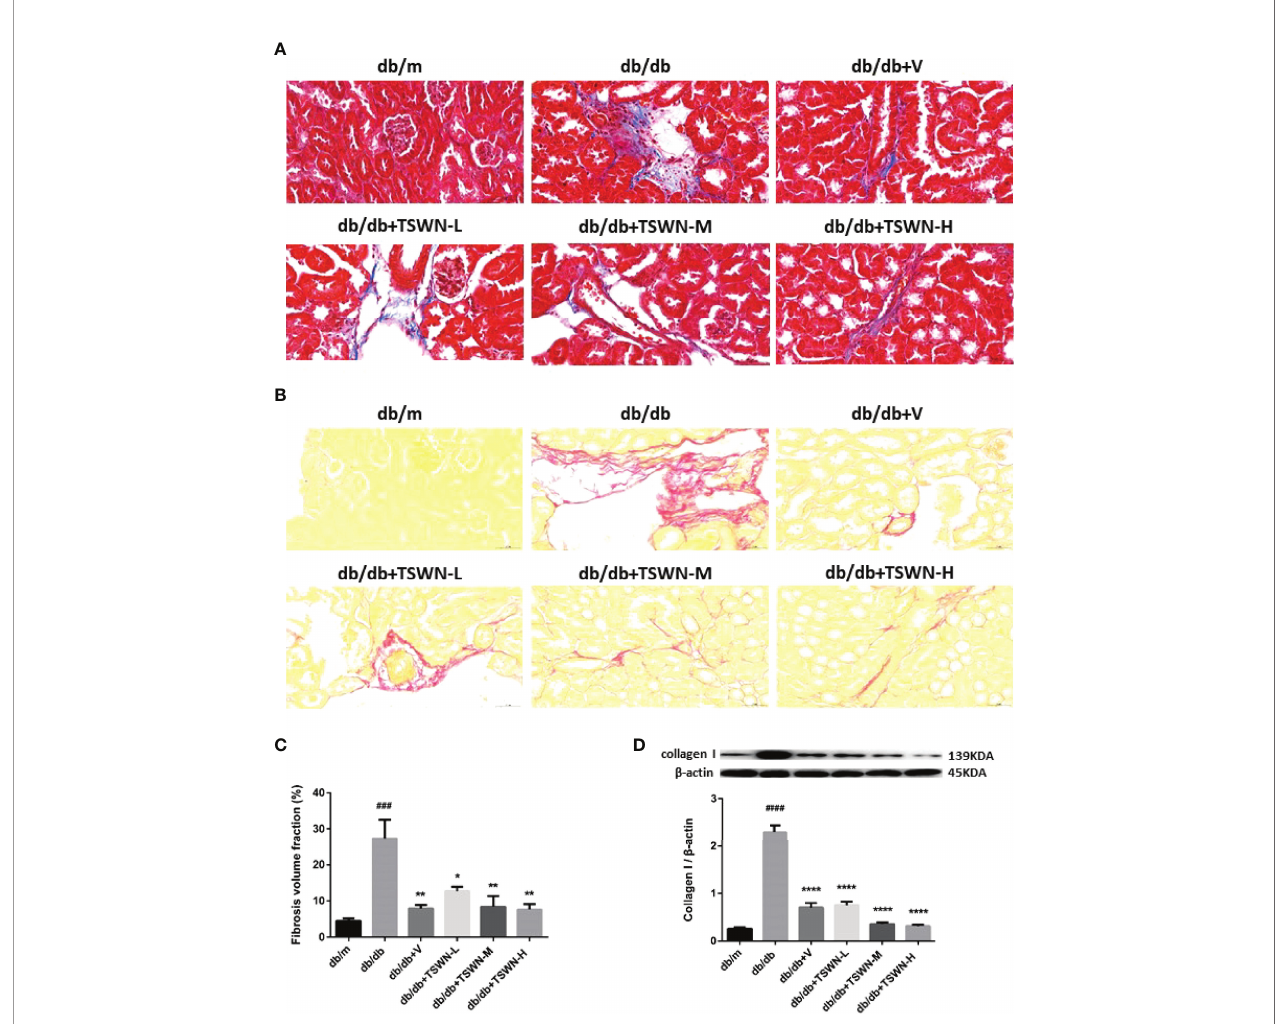
FIGURE 4 | Fibrosis in mouse kidneys. (A) Representative photographs of renal fi brosis measured by Masson ’ s staining. (B) Representative photographs of renal fi brosis measured by Sirius red staining. (C) Quanti fi cation of renal fi brosis. (D) Representative photographs and quanti fi cation of collagen I in mouse kidneys detected by western blot. n = 6 mice/group. ### P < 0.001, #### P < 0.0001 vs db/mgroup; *P < 0.05, **P < 0.01, ****P < 0.0001 vs db/db group. Db/m, db/m mice; db/db, db/db mice; db/db+V, db/db mice with valsartan treatment; db/db+TSWN-L, db/db mice with low dose TSWN treatment; db/db +TSWN-M, db/db mice with middle dose TSWN treatment; db/db+TSWN-H, db/db mice with high dose TSWN treatment. Data are means ±